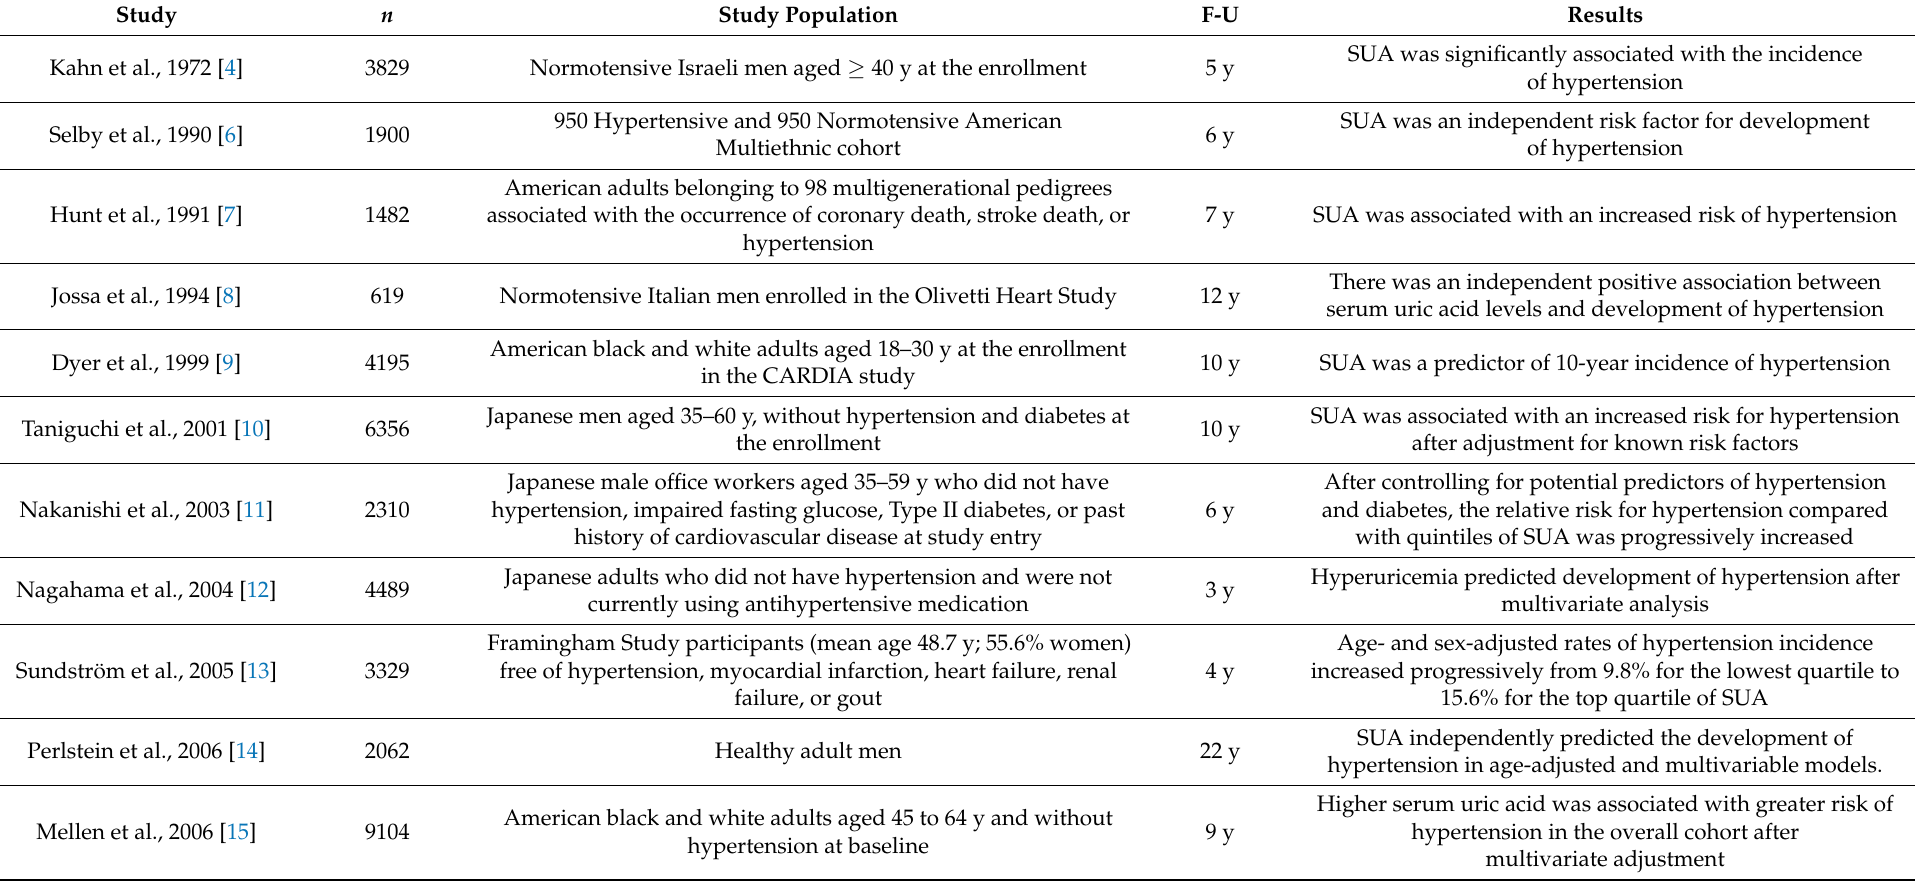
Table 1. Studies on the prognostic role of UA in